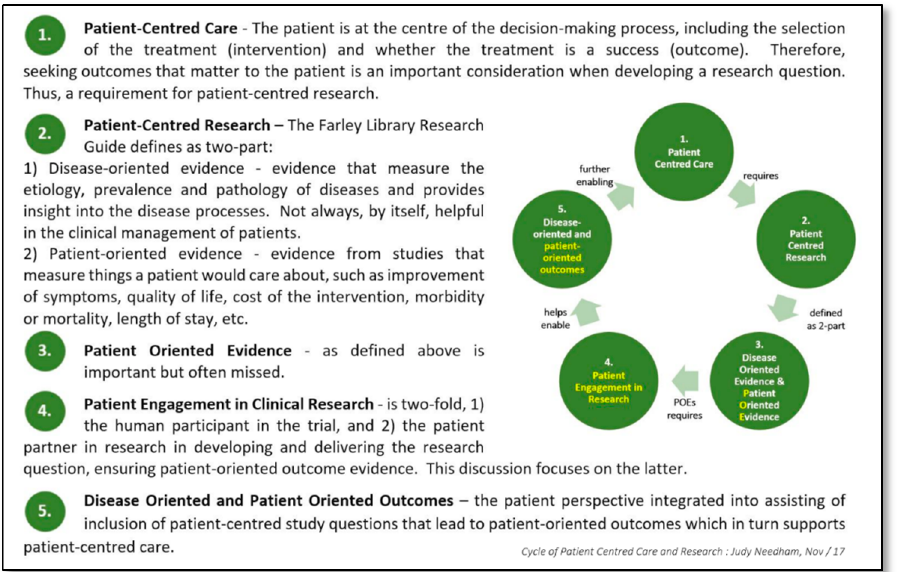
Figure 1. The Value of Patient Engagement in Research.